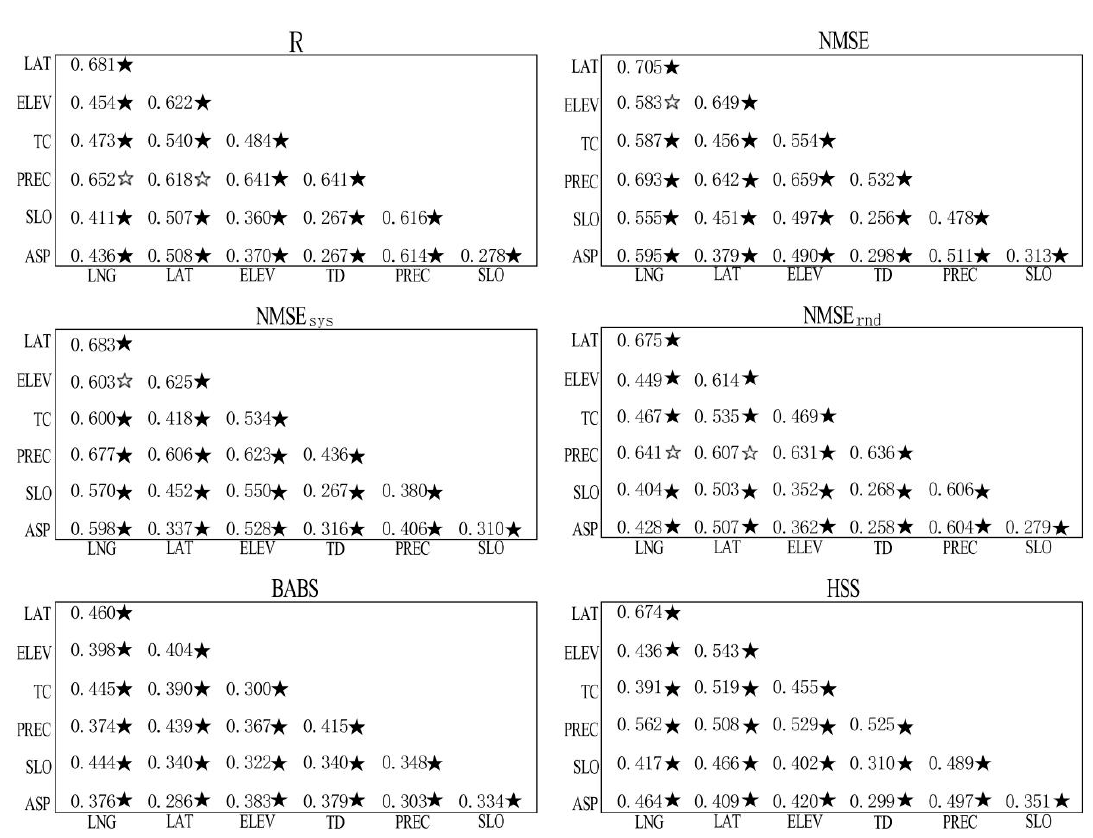
13 of 19 Figure 11. Result of the factor detector of accuracy indicators.